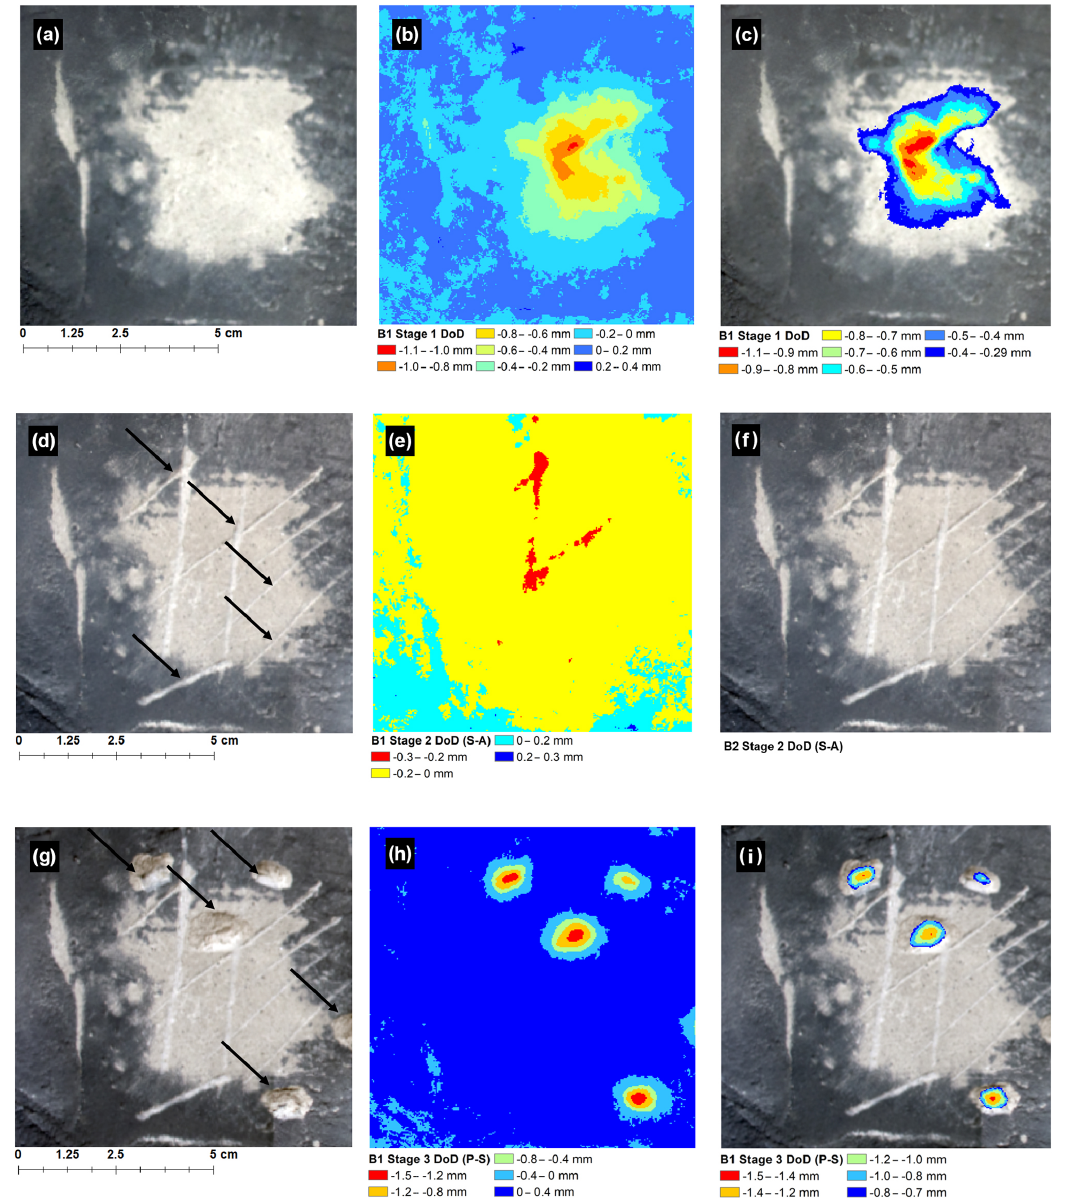
Figure 3. (a) B1 Stage 1 orthophoto showing abraded surface of simulated platform surface (light grey). (b) DoD for B1 Stage 1 before thresholding at LoD and the thresholded DoD (c) . (d) B1 Stage 2 orthophoto showing the location of scratches, (e) B1 Stage 2 DoD before thresholding, and (f) the DoD shown in (e) thresholded at LoD. (g) B1 Stage 3 orthophoto showing locations of percussions. (h) B1 Stage 2 DoD before thresholding at the LoD and the thresholded DoD (i)